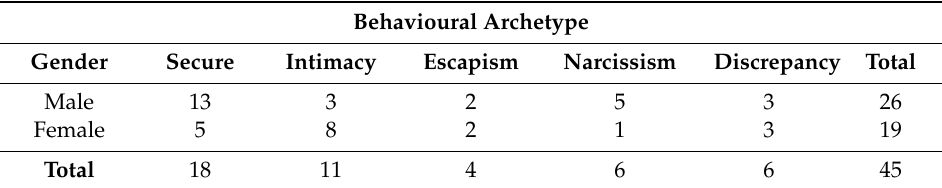
Table 13. Participants summary by behavioural archetype and